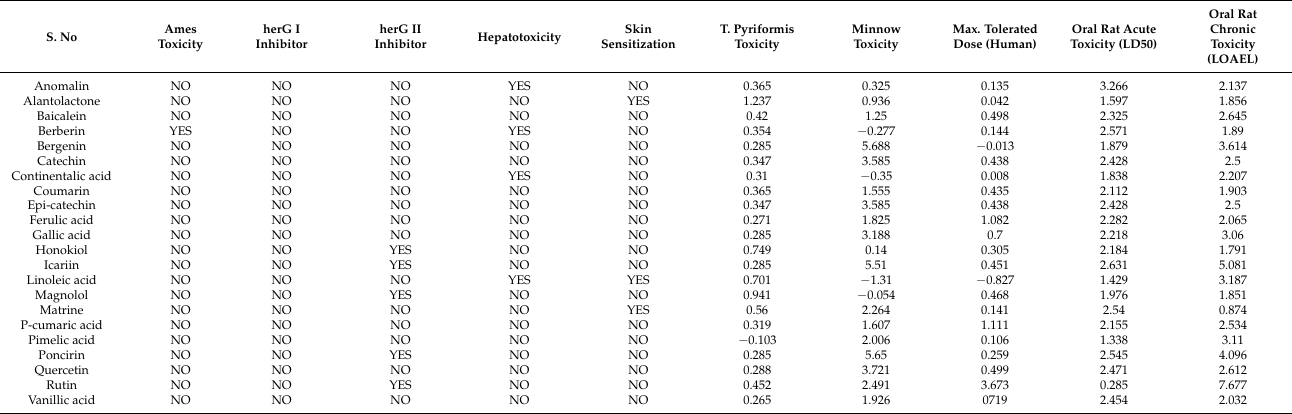
Table 2. The toxicity assessment of the selected compounds using computational assessment.